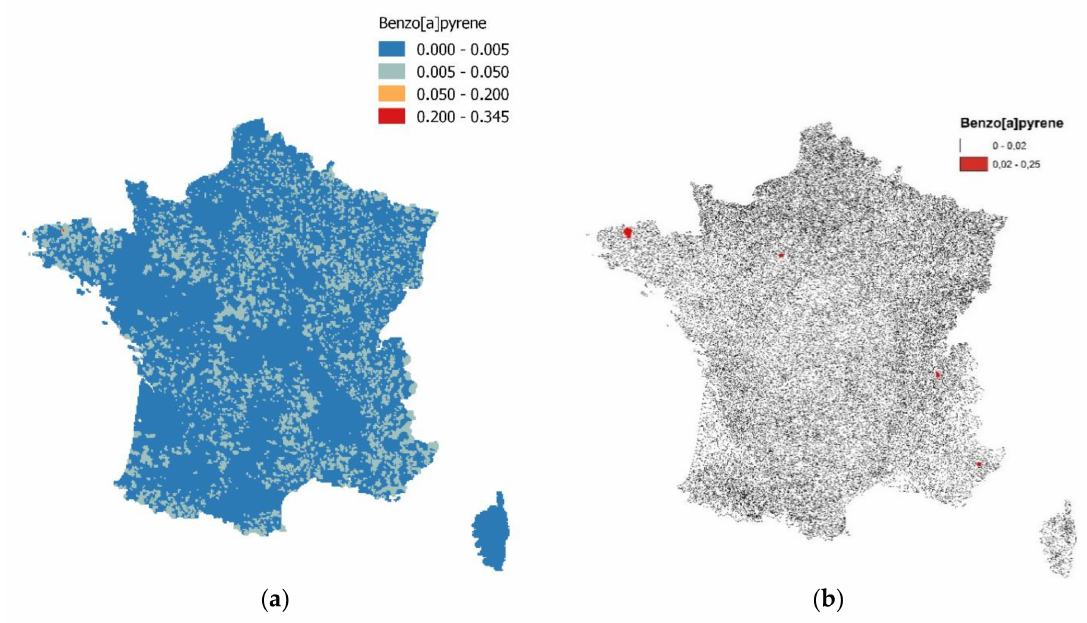
Figure 3. B[a]P concentration maps (mg/L) in water in France, ( a ) for each municipality, and ( b ) with the highlighted highest values.